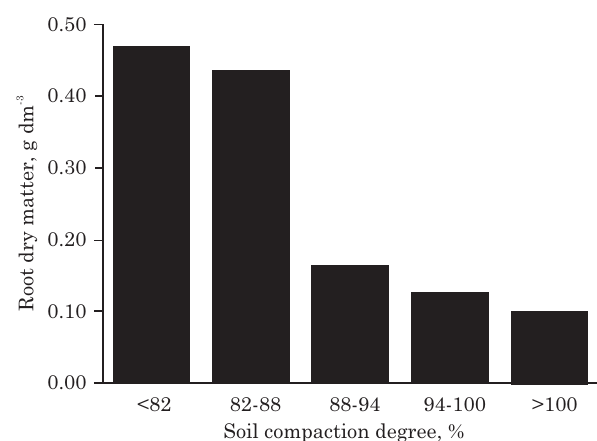
Figure 1. Distribution of sugarcane root dry matter according to the soil compaction degree in management systems.